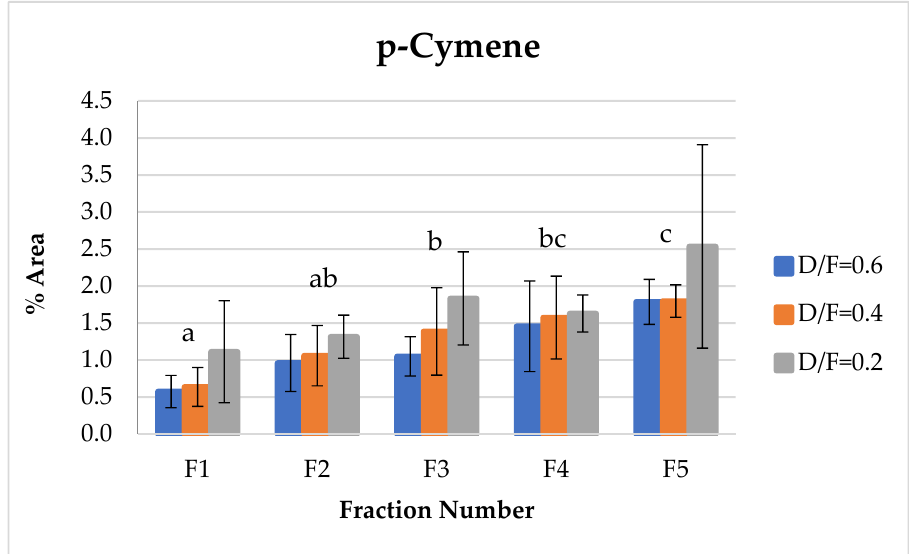
Figure 11. Abundance profile vs. number fraction for p-cymene. The results are the average of three replicates ± standard deviation. Different letters over a column indicate statistical differences (Tukey, p < 0.05).